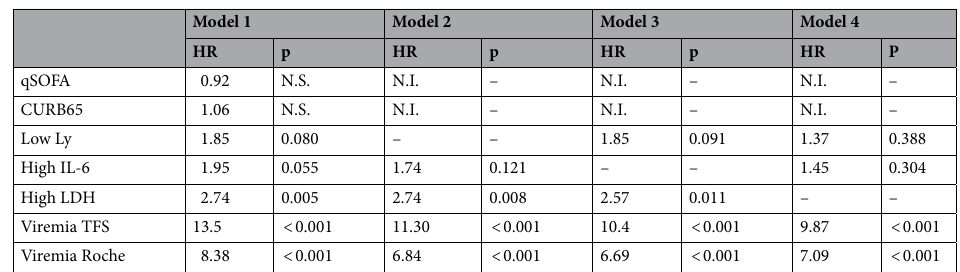
Table 3. Mortality predictive value of viremia compared to other factors. CURB65: confusion-urea-respiratory rate-blood pressure-65-years-old index; HR: Hazard Ratio; p: p-value; N.S.: not significant; N.I.: not included; Low Ly.: low total lymphocyte count; IL-6: interleukin-6; LDH: lactate dehydrogenase; qSOFA: quick sepsis related organ failure assessment; TFS: Thermo Fisher Scientific. Model 1 adjusted by age, sex and Charlson index. Model 2 adjusted by age, sex, Charlson index and low total lymphocyte count. Model 3 adjusted by age, sex, Charlson index and high IL-6. Model 4 adjusted by age, sex, Charlson index and high LDH.